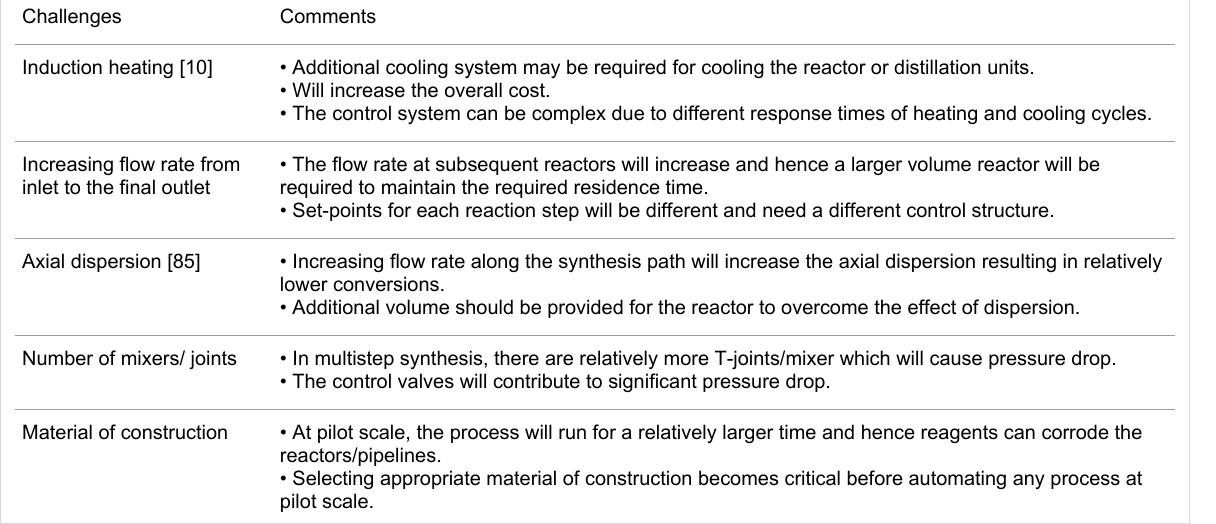
Table 1: Common challenges that need to be addressed before automating any